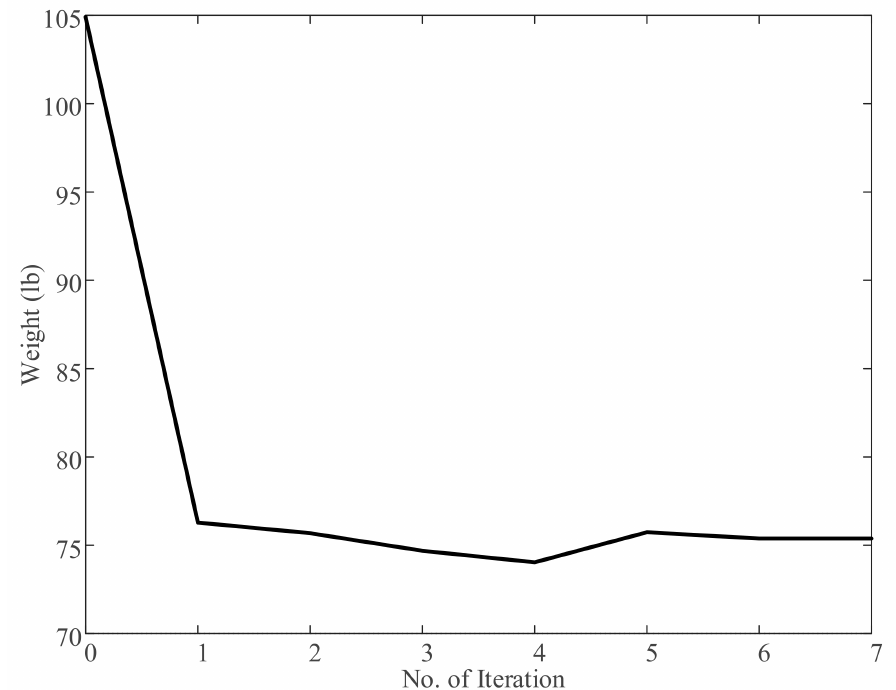
Figure 10. Iteration history for the 15-bar